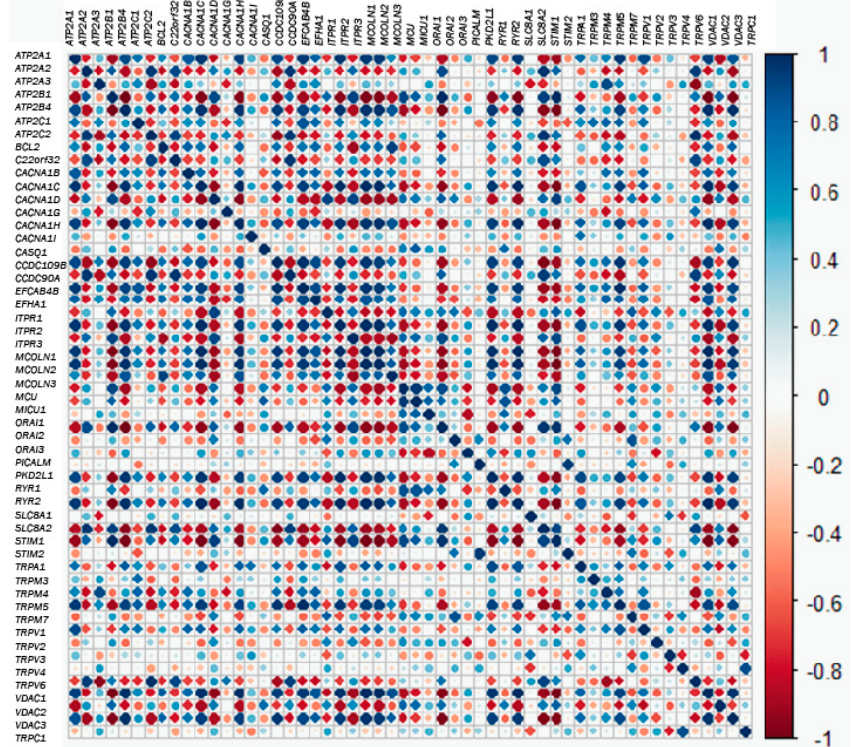
Figure 5. Correlation or co-regulation between couples of genes. The larger the circle and the darker the color, the higher the correlation (either positive in blue or negative in red) between each pair of genes.